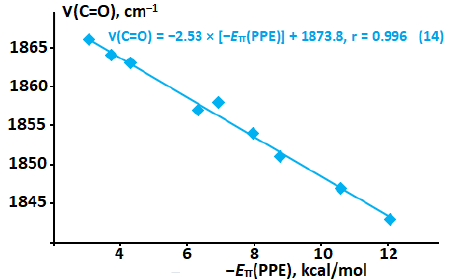
Figure 10. Dependencies of the ν C=O vibrational frequency on − E π (PPE) for subseries Ia of the studied compounds.